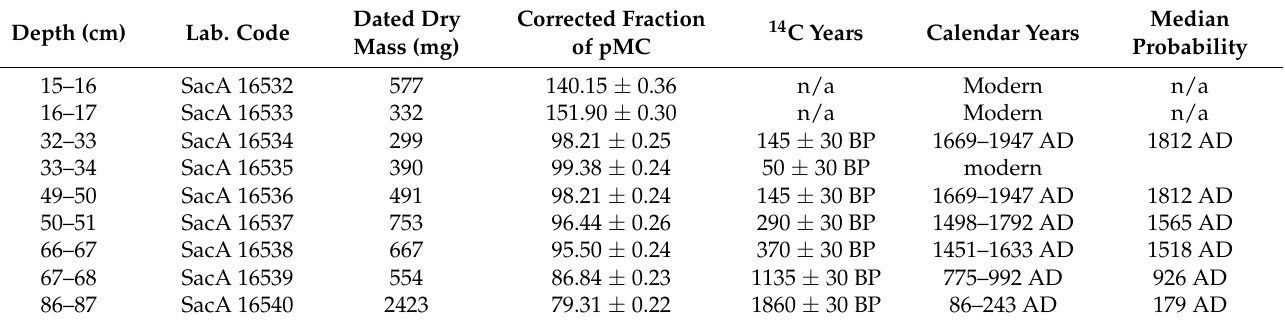
Table 1. Radiocarbon dating of the Caroux peat; all AMS measurements were conducted on decom- posed plant fibres and bryophytes aside from the 86–87 cm sample, where the dated sediment was gyttja. Dating was performed at the LMC14 lab (Gif-sur-Yvette, France). Plant macroremains were extracted using hot KOH (7%) and sieved at 200 µ